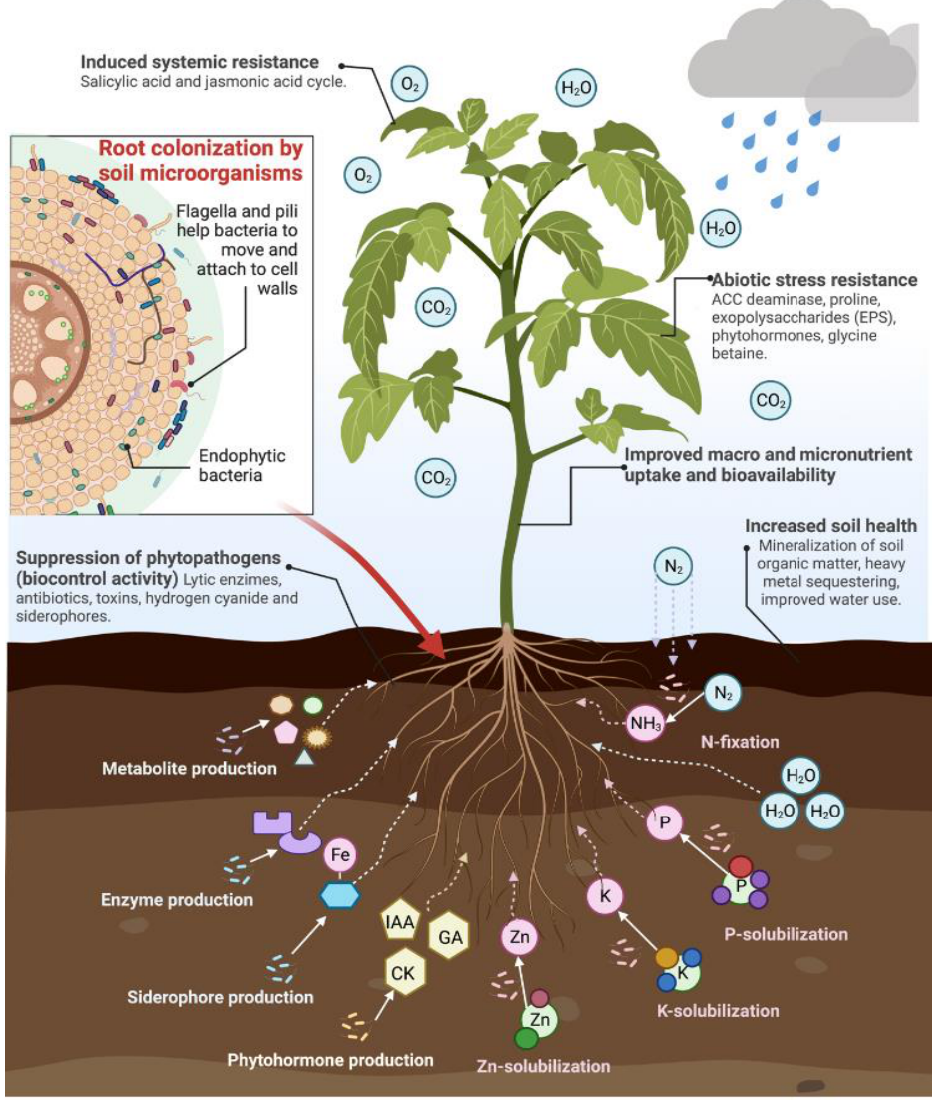
Figure 3. Plant growth and health-promoting mechanisms of soil microorganisms. Fe: iron, IAA: indole acetic acid, CK: cytokinin, GA: gibberellic acid, Zn: zinc, K: potassium, P: phosphorus, NH 3 : ammonia, N 2 : atmospheric nitrogen. Figure created with